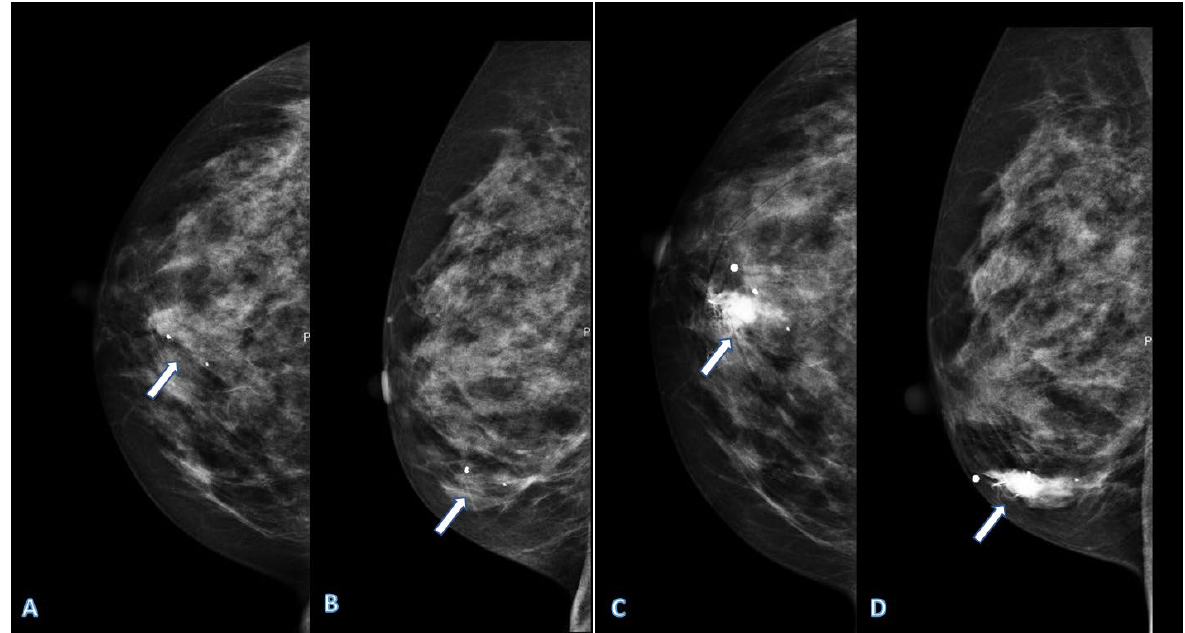
Figure 1. Digital mammography of a right breast shows some calcifications in an area (arrows) with increased radiopacity in cranio-caudal ( A ) and medio-lateral ( B ) mammograms. Contrast enhanced mammography shows an increased enhancement in the same area ( C , D ), which is suspicious for breast cancer.